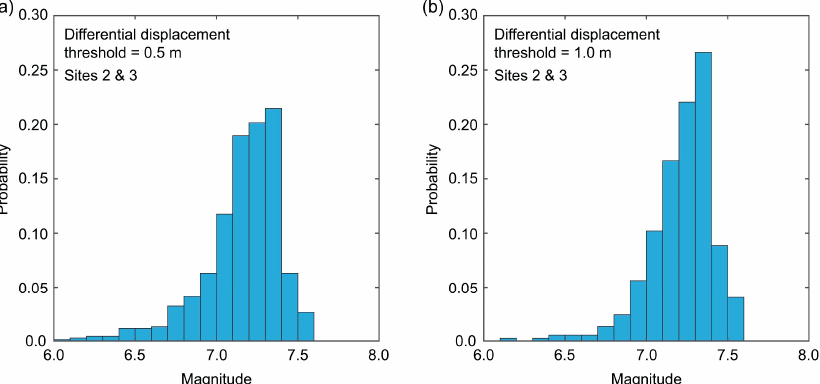
Figure 11. Magnitude distributions of fault-rupture events that produce total differential displace- ments for Sites 2 and 3, exceeding the threshold values of 0.5 m ( a ) and 1.0 m ( b ).